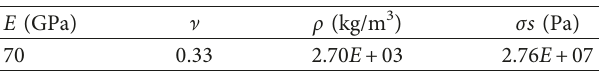
Table 2: The material properties of the aluminium honeycomb core.